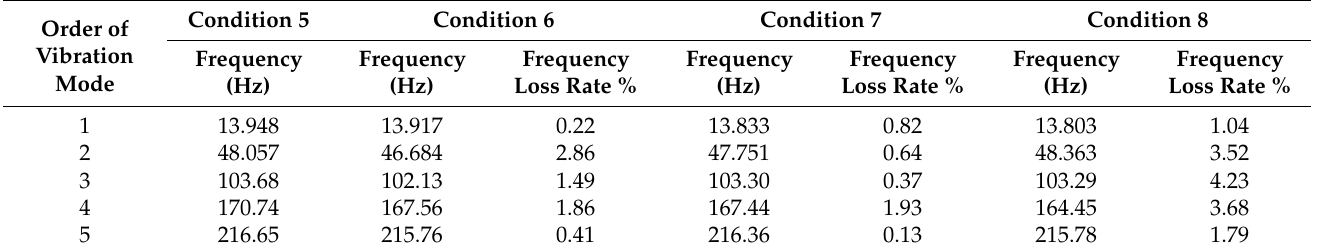
Table 4. Frequency loss rates under different stiffening